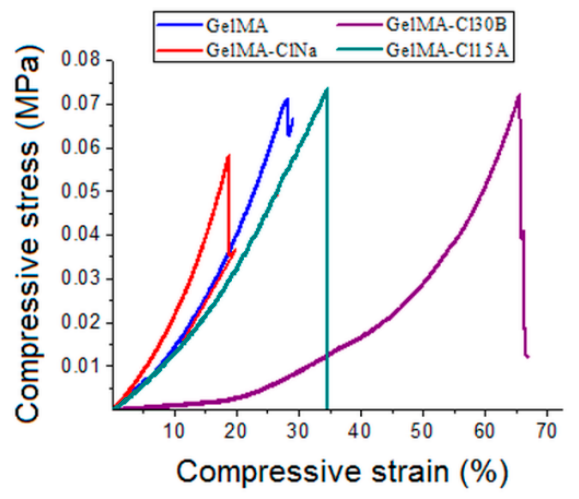
Figure 8. Compressive stress versus compressive strain of samples at equilibrium (37 °C).